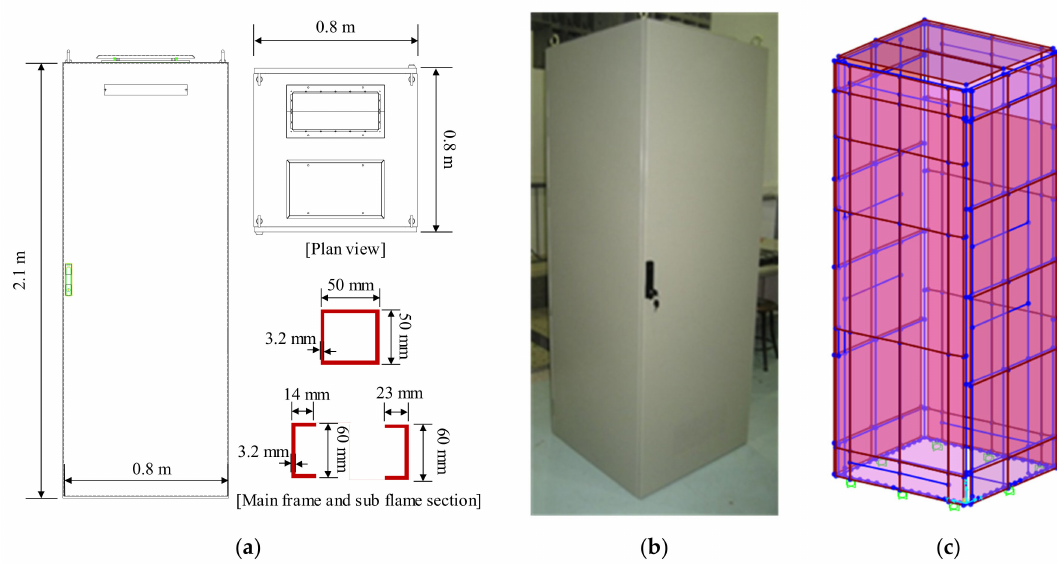
Figure 2. Electrical cabinet model: ( a ) Dimensions of the electrical cabinet; ( b ) Prototype of the electrical cabinet; and, ( c ) Finite element